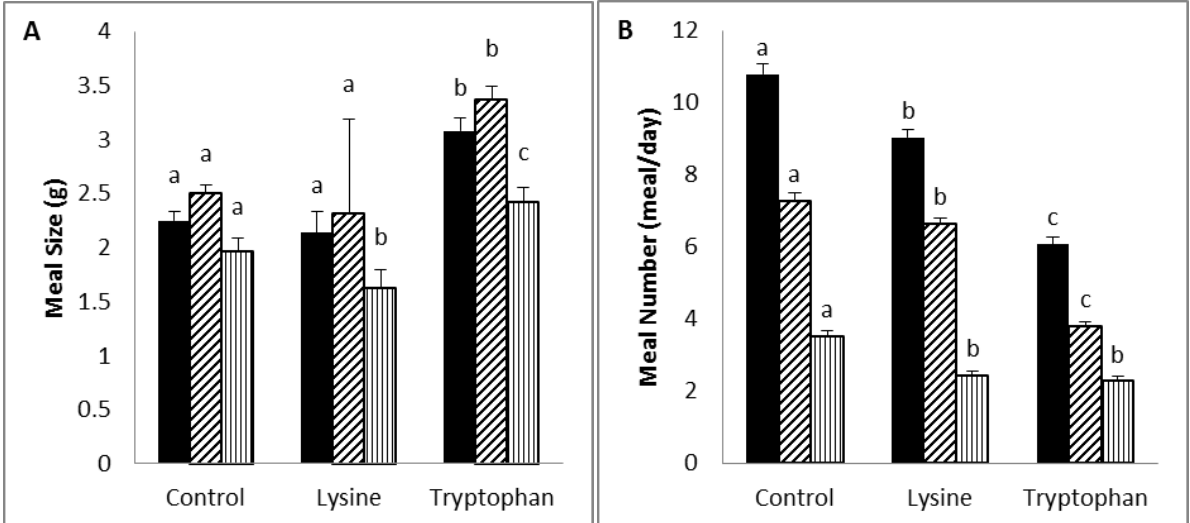
Figure 1. Mean meal size (g) ( A ) and meal number ( B ) of rats fed on diets supplemented with 5% lysine or